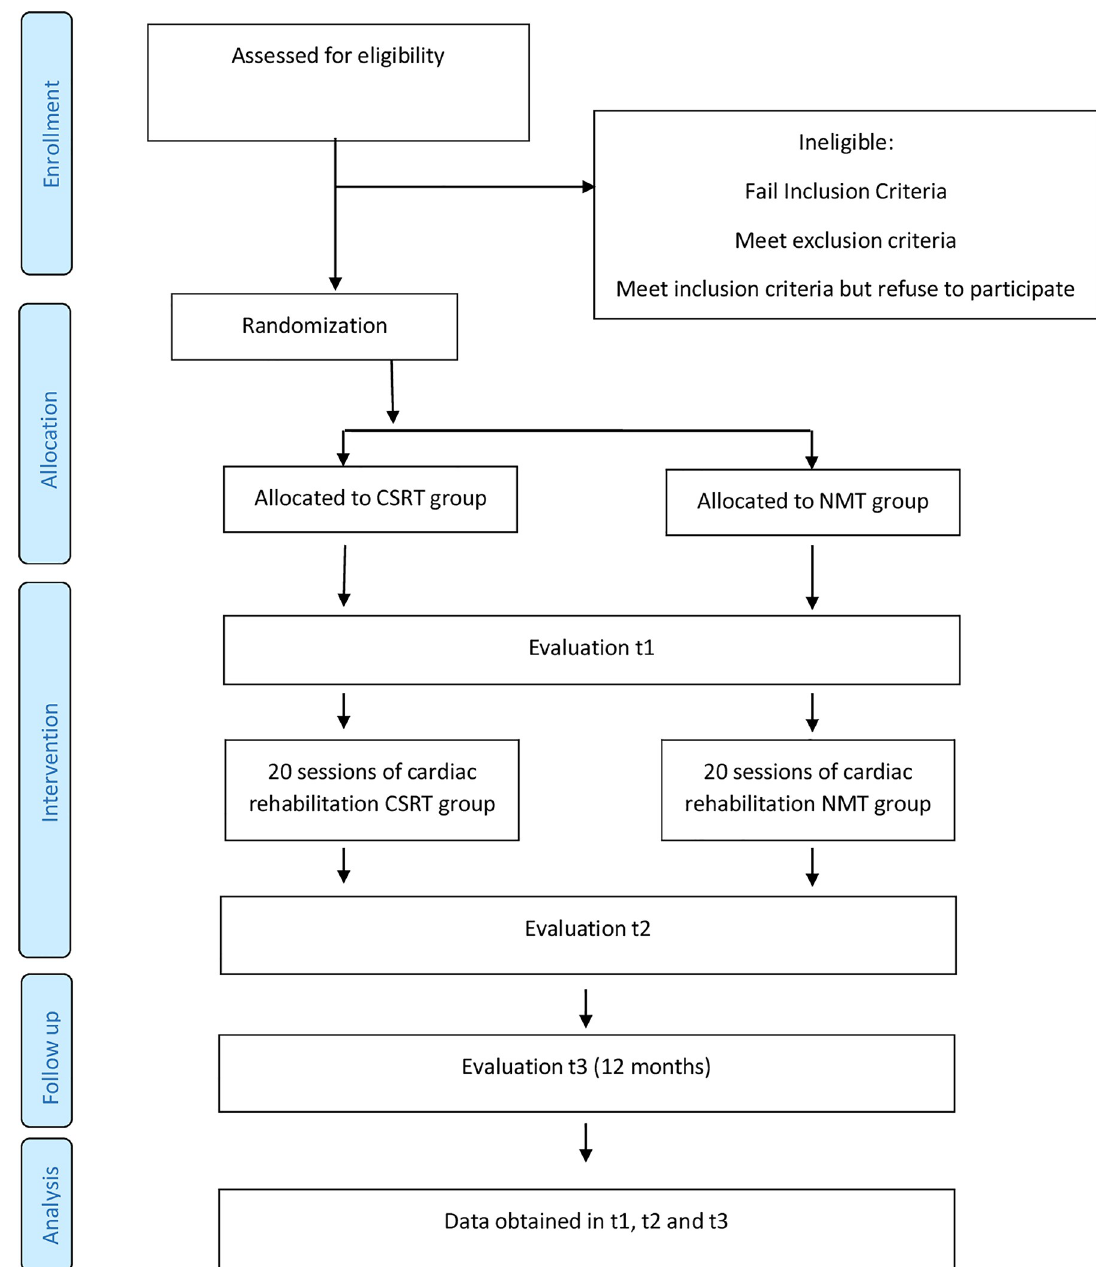
Fig 1. Protocol timeline implemented for the study. CSRT: classic strength-resistance training; NMT: neuromuscular training.